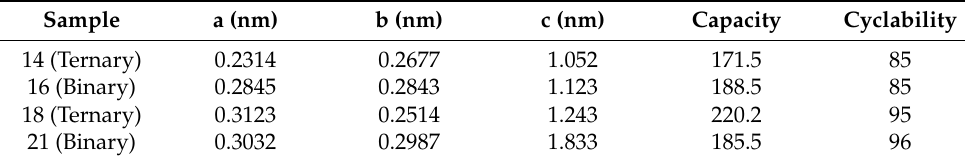
Table 3. Lattice Parameters of samples 14, 16, 18 and